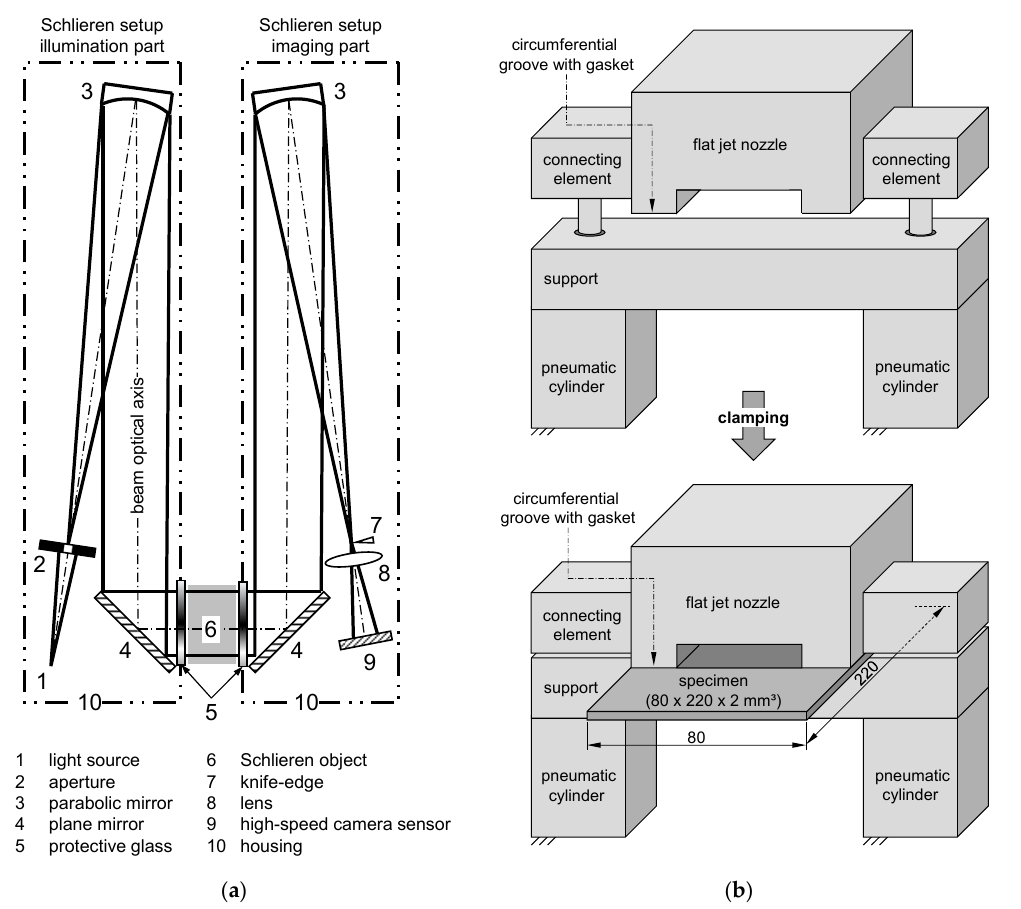
Figure A2. ( a ) z-type Schlieren setup used during the investigations; ( b ) schematic depiction of clamping device with flat jet nozzle and specimen.